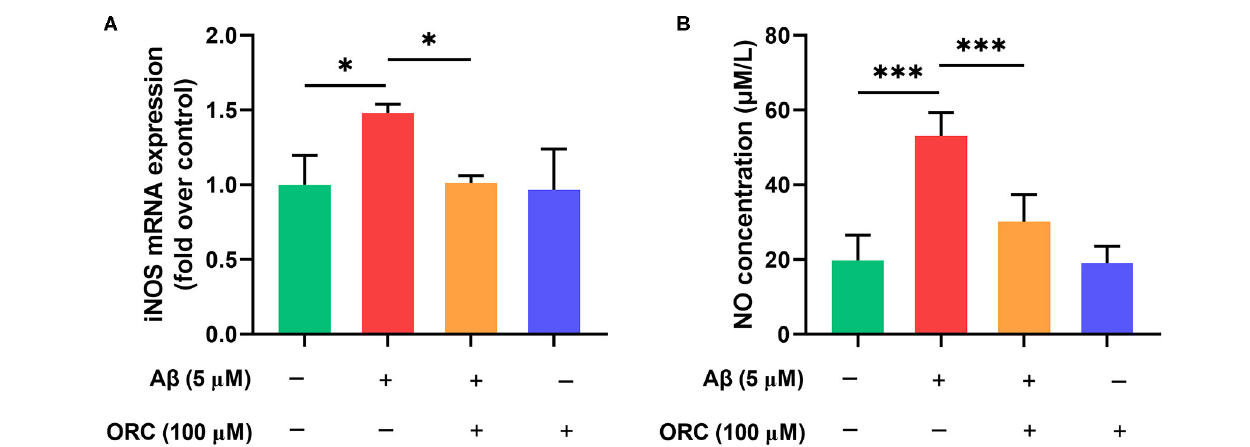
FIGURE 5 | Inhibitory effects of oxiracetam (ORC) on the oxidative stress induced by A β in BV2 cells. BV2 microglial cells were treated with A β in the presence or absence of ORC. (A) The inducible nitric oxide synthase (iNOS) mRNA level was determined using qRT-PCR ( n = 3 for all groups). (B) The level of nitric oxide (NO) in supernatants was examined using the NO assay ( n = 5 for all groups). * p < 0.05 and *** p <